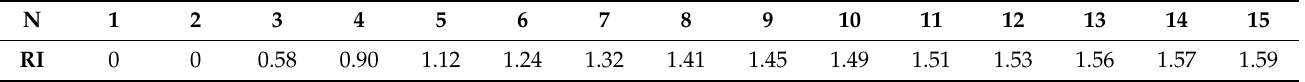
Table 2. The random consistency index (RI)